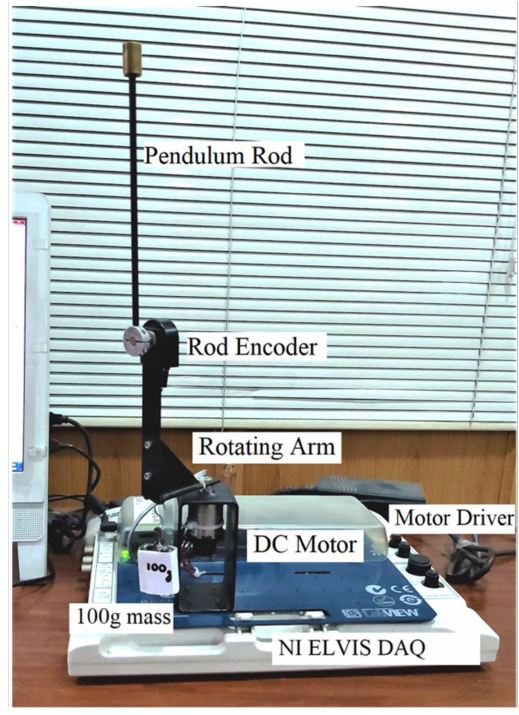
Figure 3. QNET rotary pendulum